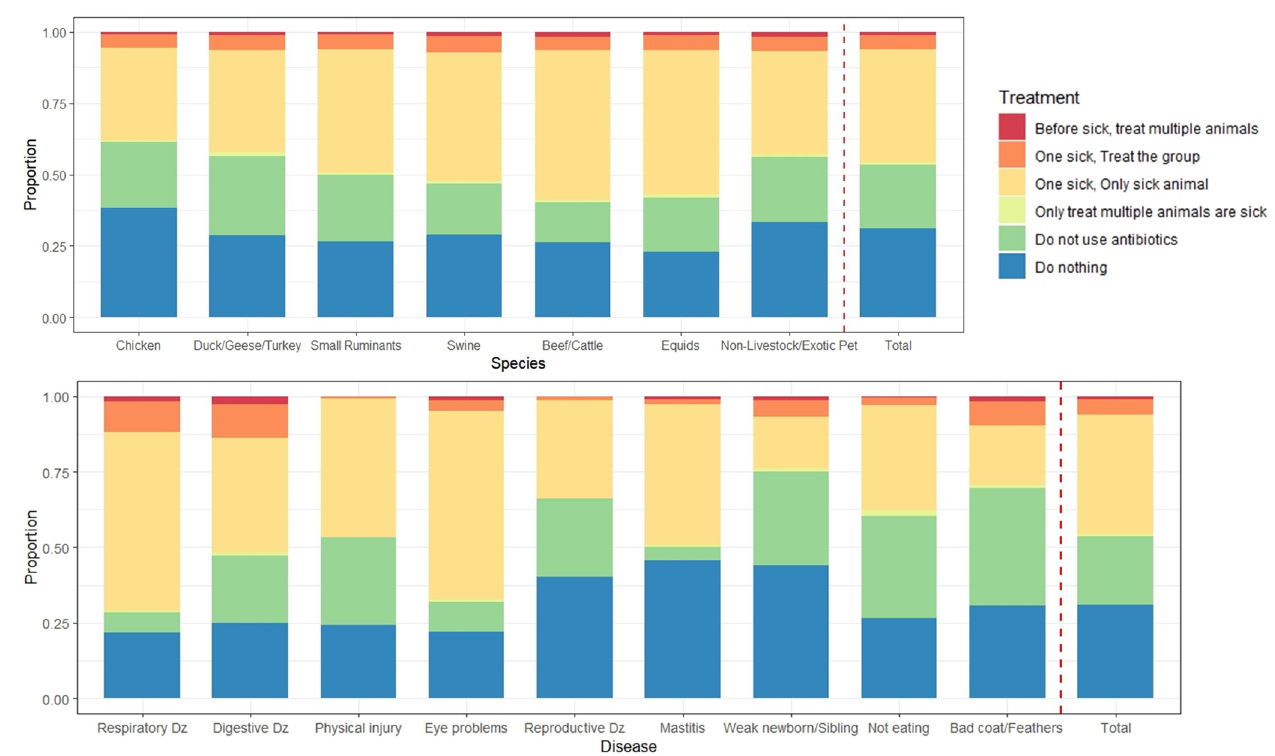
Fig 3. Summary of antibiotic treatment to livestock/poultry by type of diseases and species.